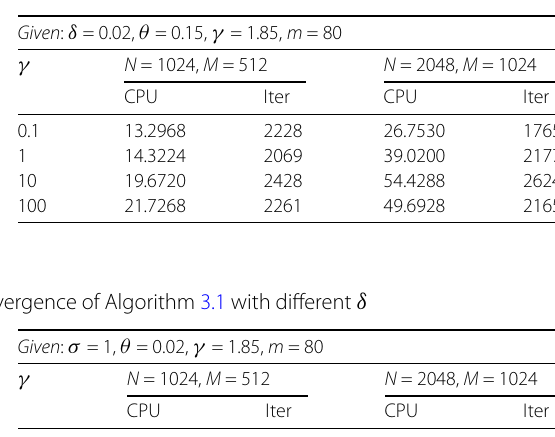
Table 4 The convergence of Algorithm 3.1 with different σ